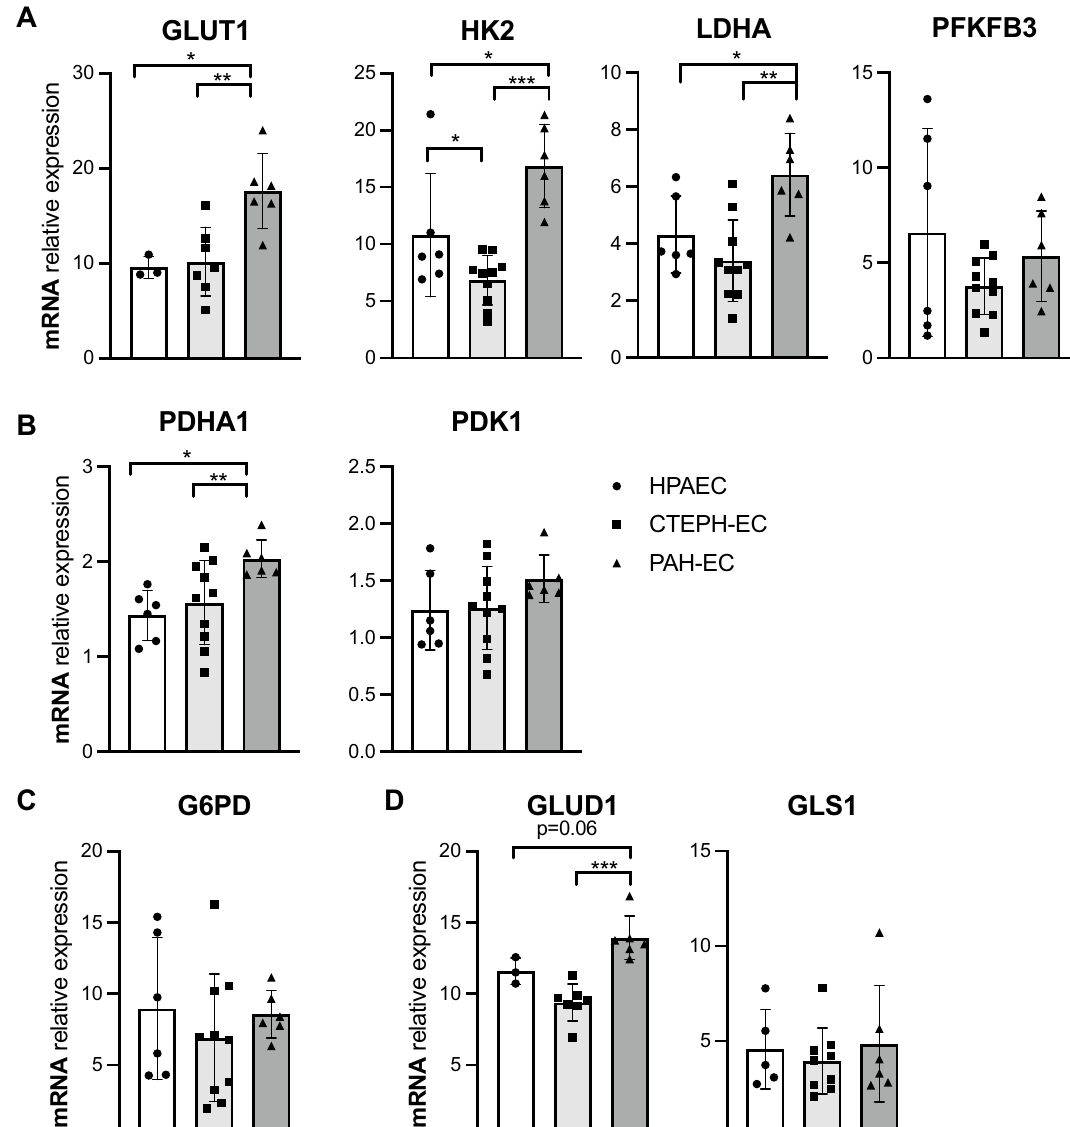
Figure 2. Gene expression of key metabolic enzymes. ( A ) mRNA expression levels of GLUT1, HK2, LDHA and PFKFB3 in CTEPH-EC, PAH-EC and HPAEC. ( B ) mRNA levels of PDHA1, PDK1 in all three groups. ( C ) G6PD mRNA levels were found similar between all three groups. ( D ) mRNA levels of metabolic enzyme GLS1 and GLUD1 in all three groups studied. CTEPH-EC, n > 7; PAH-EC, n = 6; HPAEC, n > 3; One-way ANOVA, data is expressed as mean ± SD, p < 0.05 = *; p < 0.01 = **; p < 0.001 = ***. Statistical analysis was performed with GraphPad Prism 7 software, version 7.0e, serial number:GP7-0,633,739-R###-#####,https:// www. graph pad.